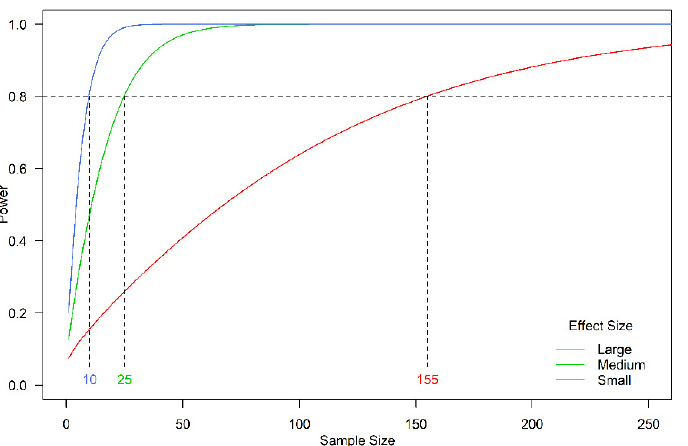
Figure 2. Relationship between the power of an experiment for varying sample size. This assumes a one-way test of one-sample proportion, with small, medium and large effect sizes specified by 0.2, 0.5 and 0.8, respectively, corresponding to an increase in proportion (from the base level with no mitigation) of approximately 0.09, 0.22 and 0.34 respectively. The effect size for two proportions are calculated using the arcsine transformation of the proportions. Numbers in colour denote the number of white sharks that would be required to be caught and relocated in order to detect an effect size.